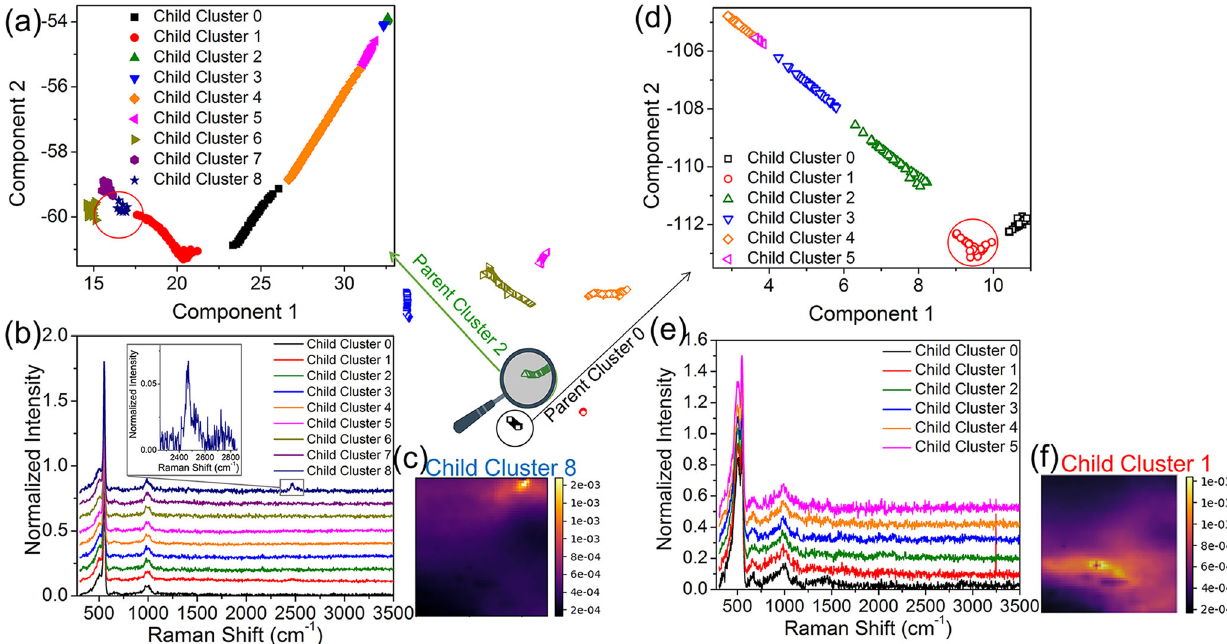
Fig. 5 The child clusters at the fi ner resolution grid. a An overview of child manifold clusters at the fi ner resolution grid, stemmed from Parent Cluster 2 and ( b ) the corresponding mean tip-enhanced Raman spectroscopy (TERS) spectra of the child clusters. The peak centered at 2435 cm -1 of Child Cluster 8 represents unique structural defects different from other child clusters. c Similarity loading of Child Cluster 8 that shows a bright blob around the black singular patches in similarity loading of Parent Cluster 2 in Fig. 4. d Overview of child clusters stemmed from Parent Cluster 0 and ( e ) the corresponding mean Raman spectra of the child clusters. f The similarity loading of Child Cluster 1 that shows a bright blob around the black singular patches in Parent Cluster 0 similarity loading in Fig. 4. The color bar represents the reciprocal of Euclidean distance between the mean TERS spectrum and the as-taken TERS spectrum of each the pixel within a given cluster.